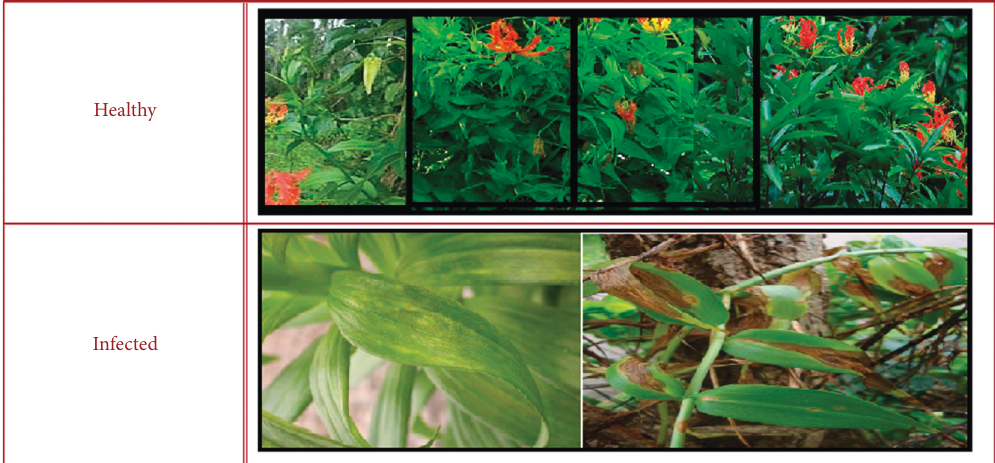
Figure 1: Dataset sample images.